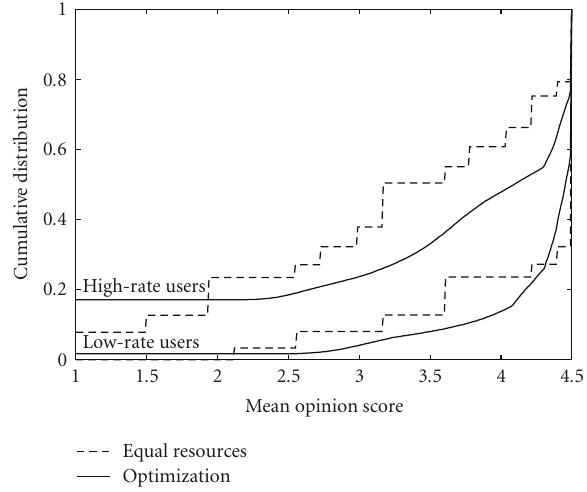
Figure 16: CDF of the perceived quality for two application classes. Both high- and low-rate users benefit from